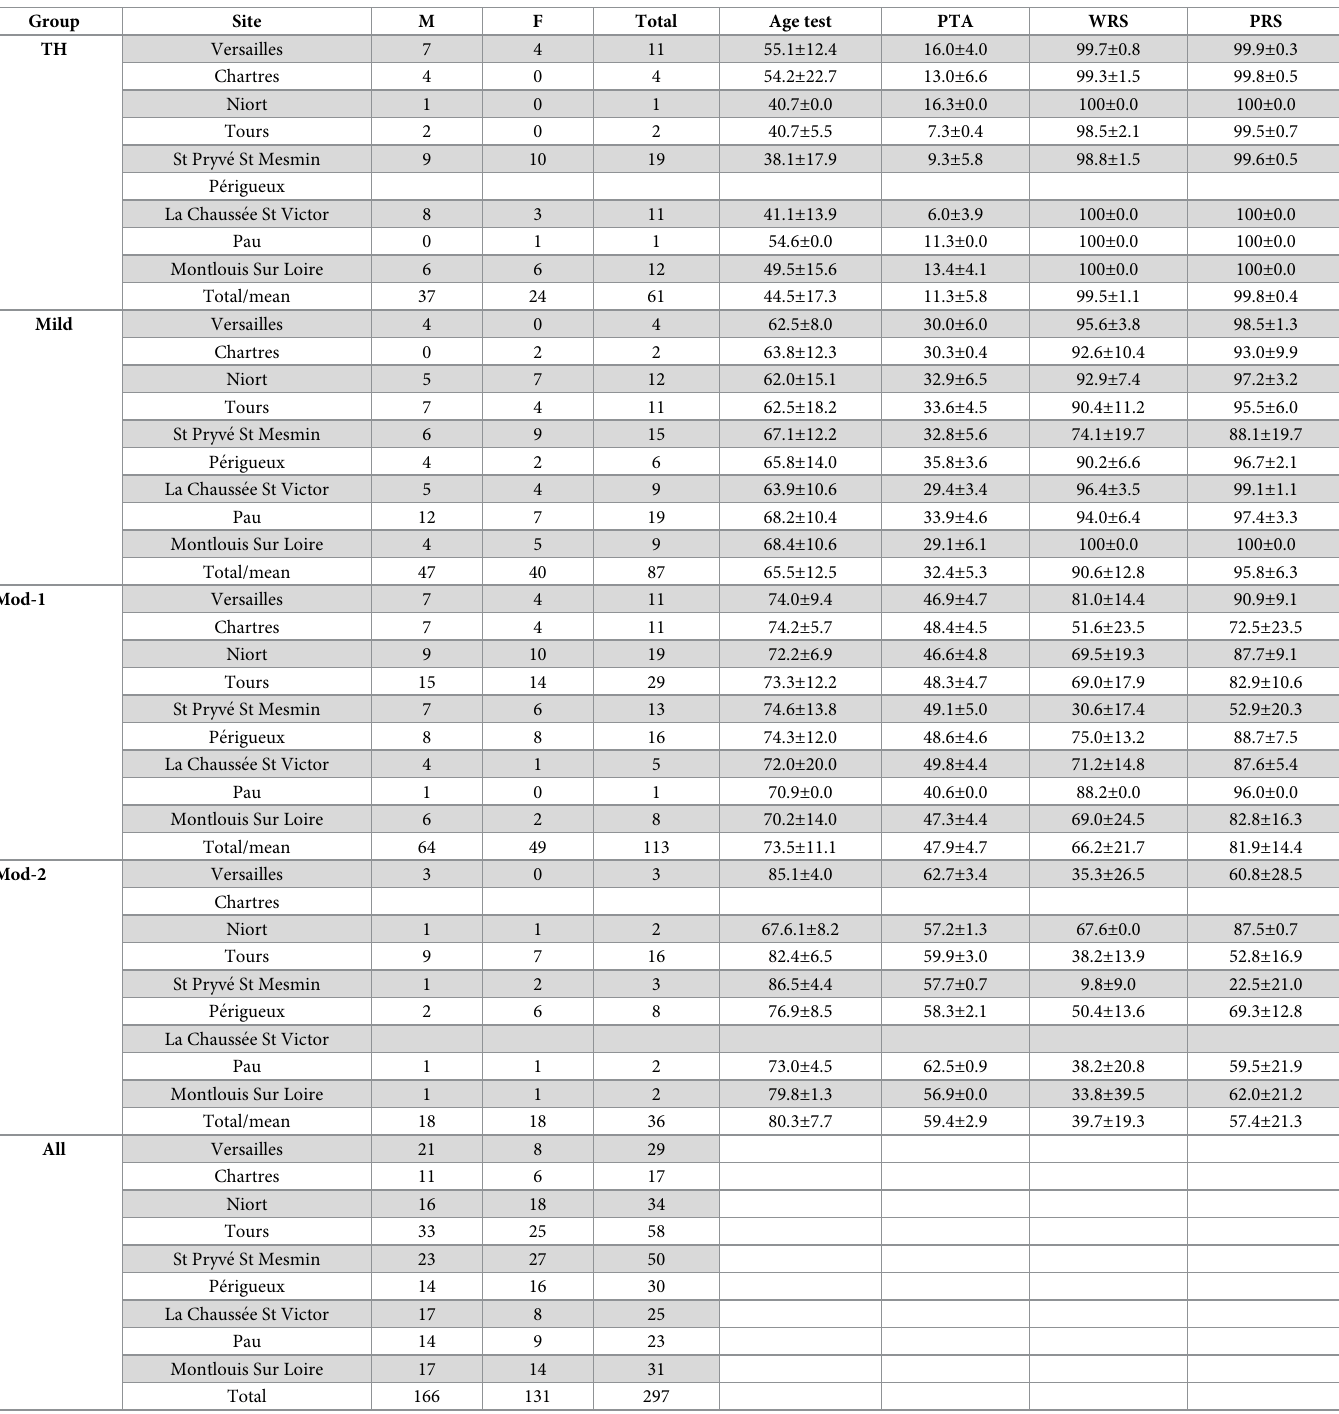
Table 1. Demographic information within and across the different hearing status groups and test sites. Data are shown for the number of male and female partici- pants, the total number of participants, mean (and standard deviation) age at testing, pure-tone average (PTA) threshold in dB HL, percent correct word recognition scores (WRS) in quiet, and percent correct phoneme recognition scores (PRS) in quiet.